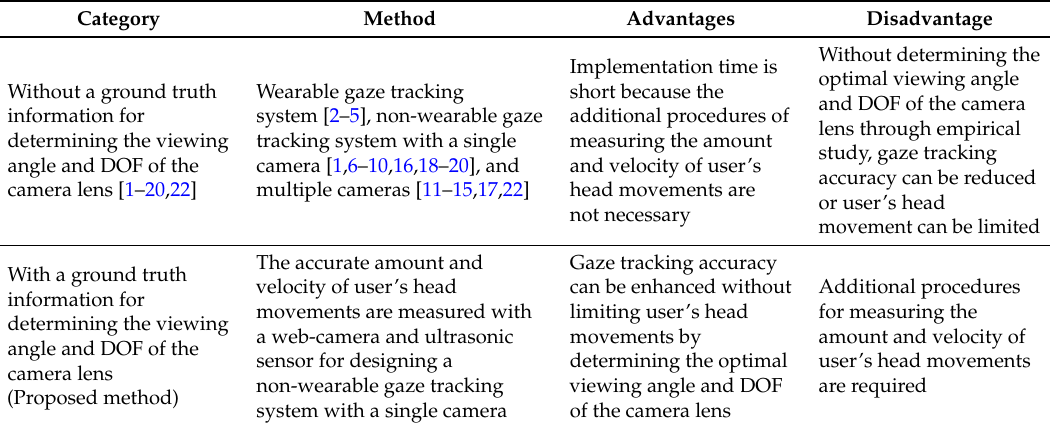
Table 1. Comparison of previous and proposed methods for designing a gaze tracking